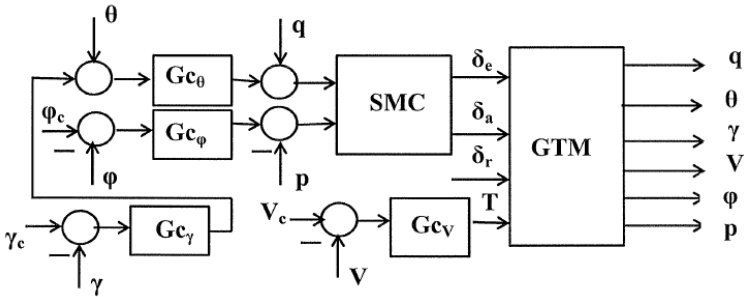
Figure 3. The control system